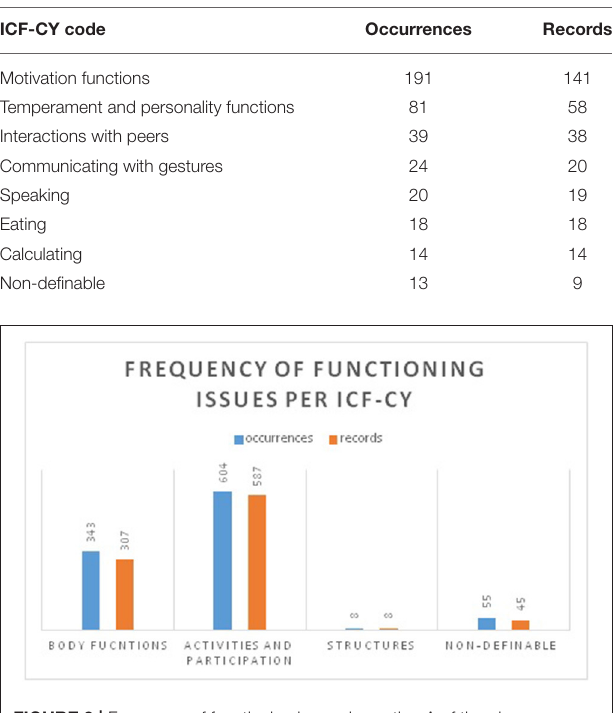
FIGURE 2 | Frequency of functioning issues in section A of the plans, matched with the ICF-CY classification